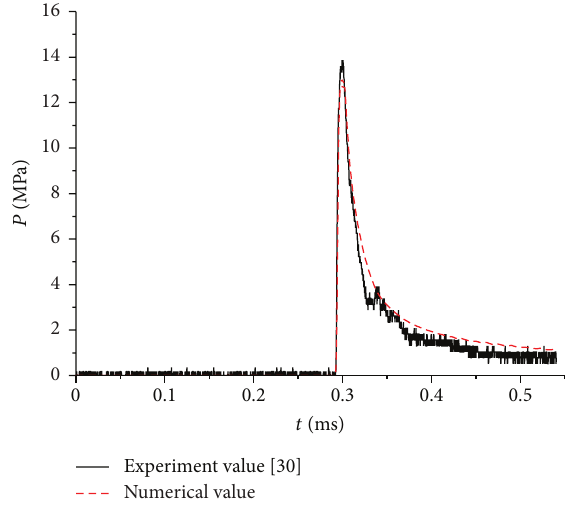
Figure 4: Pressure-time curve at test point A (numerical results are compared with experimental